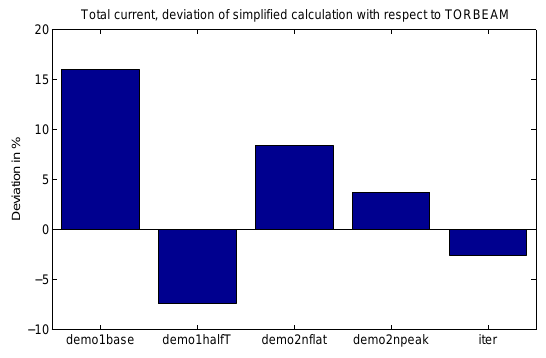
Figure 3. Deviation (in percent) between the estimated value of the current drive (calculated from a single evaluation of the ECCD e ffi ciency, using Eqs. (7) and (10) to determine the re- quired input) with respect to the current found in explicit beam tracing ECCD optimizations for the scenarios described in Table 1. The label demo1base (baseline) refers to the DEMO1 param- eters reported in the table, while demo1halfT refers to the same case with the temperature divided by